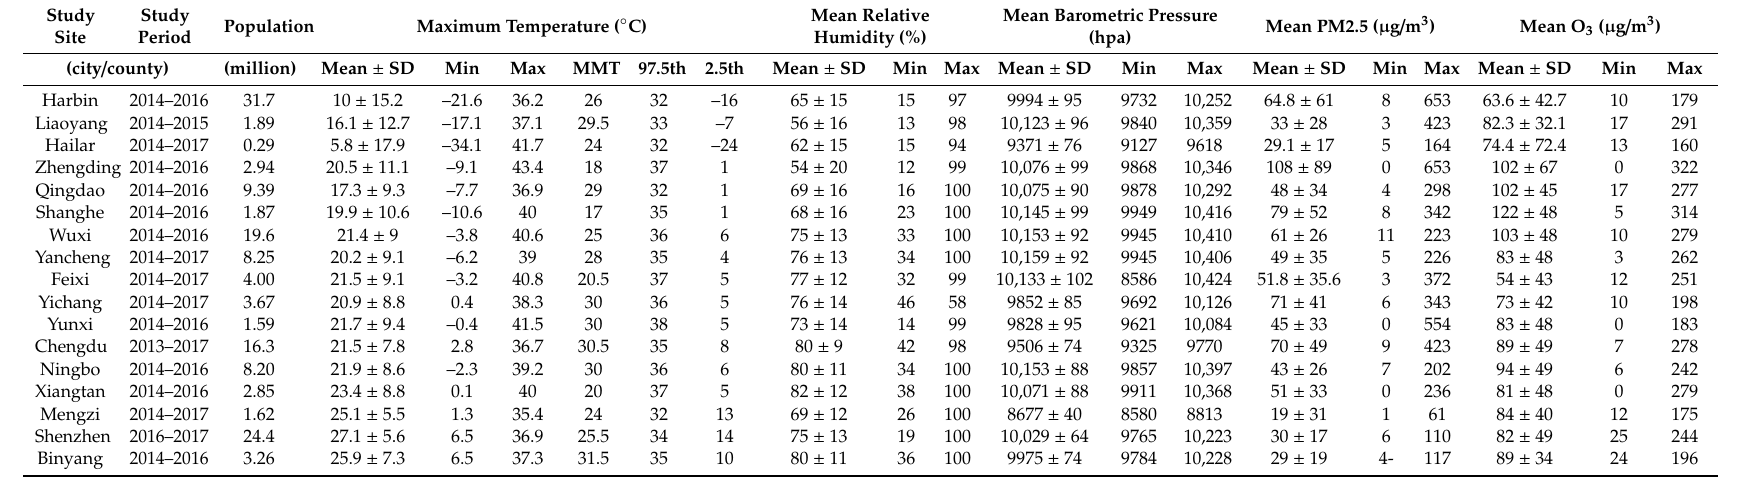
Table 1. Descriptive statistics of meteorological factors and air pollutants at 17 study sites in China, 2014–2017. MMT, minimum mortality